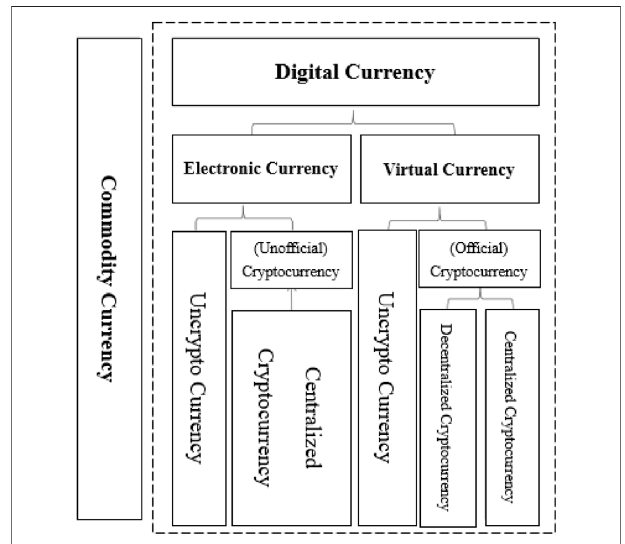
FIGURE 1 | Concept and de fi nition of